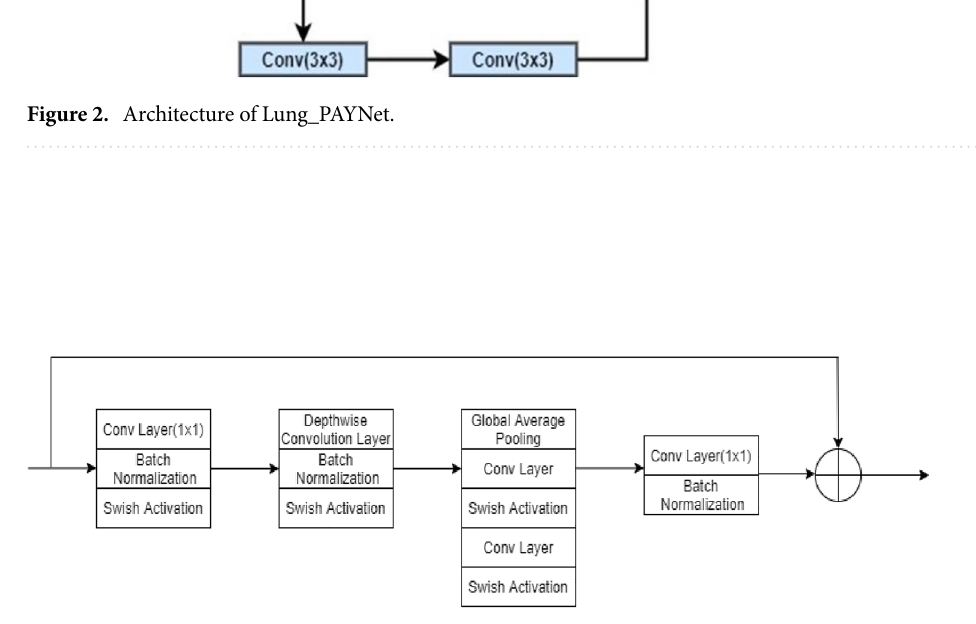
Figure 3. Layers of an Inverted Residual